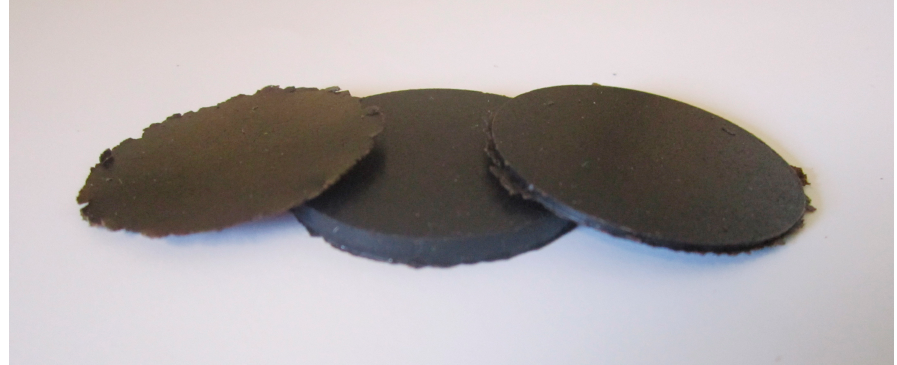
Figure 1. Compression-molded plates/films of the larva material (diameter: 35 mm, thickness from left to right: 180 µm, 3 mm and 1 mm).